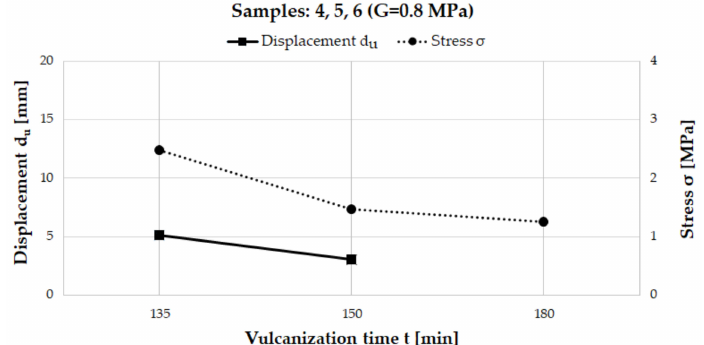
Figure 14. Test results in terms of displacement and stress for samples 4, 5, 6 (G = 0.8 MPa for various vulcanization times.